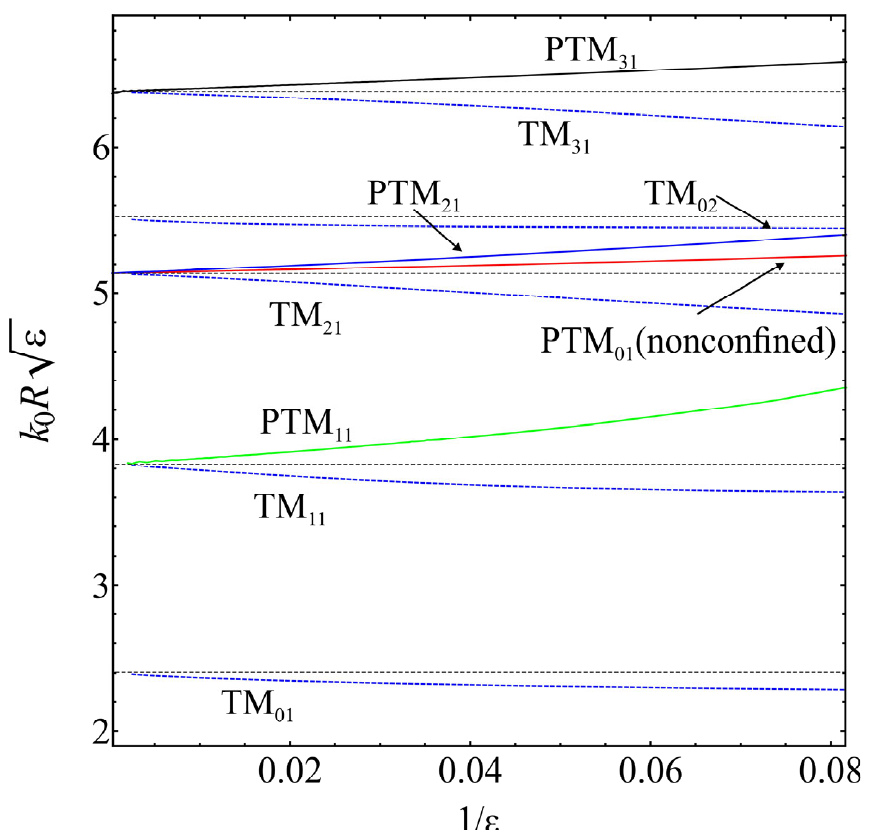
Figure 3. Dependence of the size parameter k 0 R ε for the perfect invisibility modes of TM type (PTM) on 1/ ε (solid curves). The dashed black curves show the roots of the Bessel function (confined modes). Blue dashed curves correspond to usual quasi-normal TM modes (TM). The first index m in the notation TM mn or PTM mn indicates the order of the mode, and the second index n denotes the n th root of Equation (12) in the case of PTM modes and the n th root of Equation (13) for usual TM modes. When condition (12) is met, the scattered field (16) and the scattered power become zero.